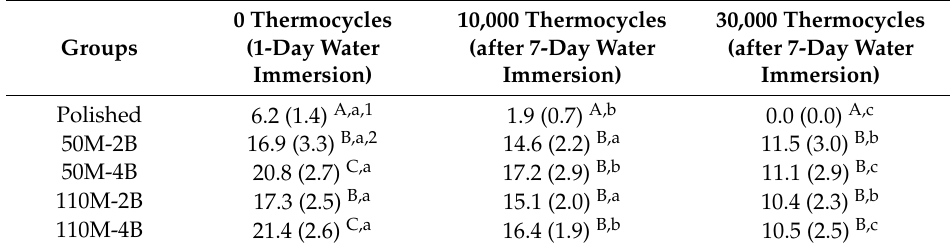
Table 2. Shear bond strength (in MPa) of the resin cement to the polished and sandblasted zirconia ceramic surfaces ( n =